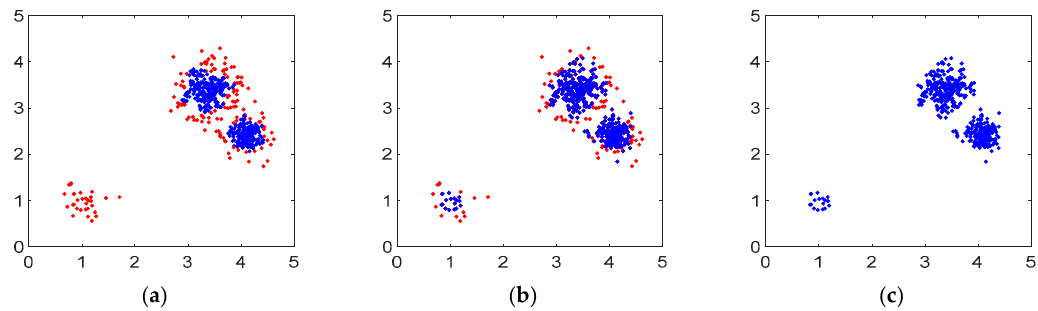
Figure 4. Comparison of boundary points determined by DBSCAN and (10): ( a ) global density; ( b ) local density; ( c ) interior points.